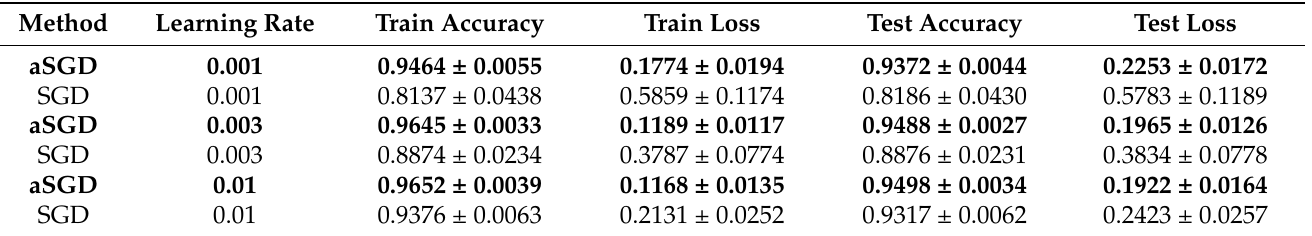
Table 1. The mean and variance of the model performance trained on MNIST images at same learning rates.